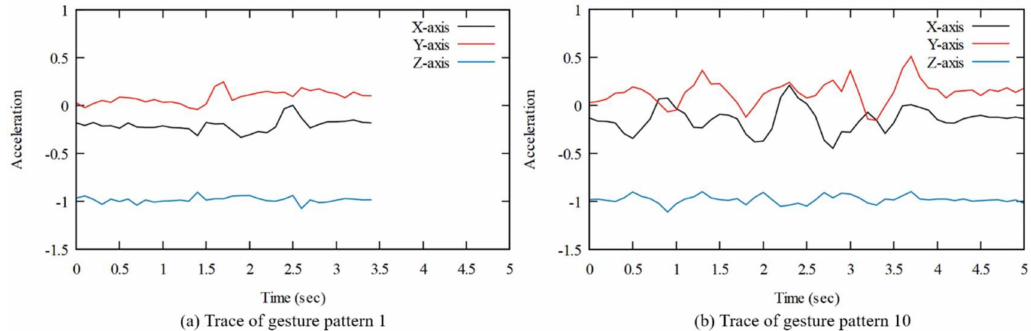
Figure 5. The graph of gesture 1 and 10